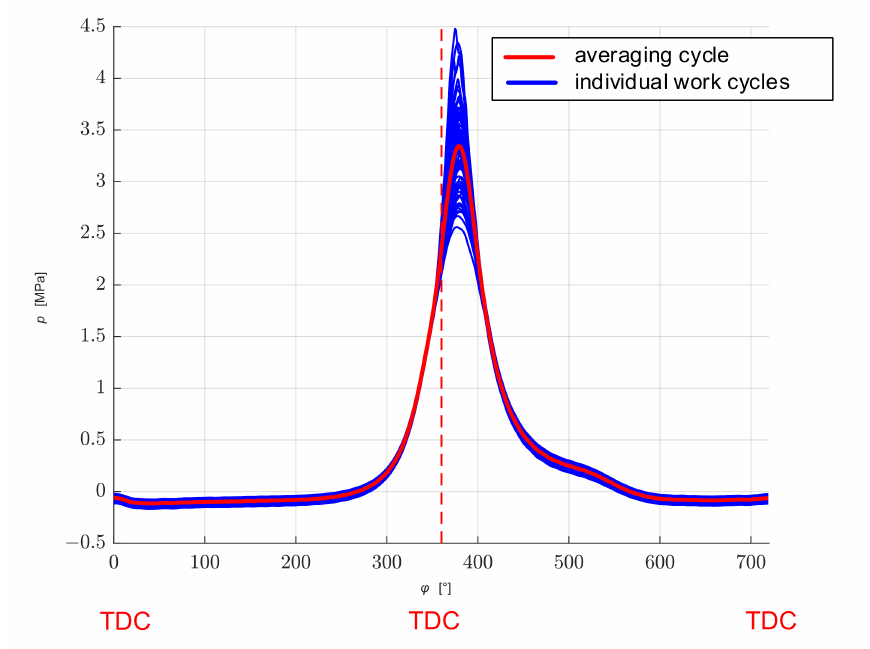
Figure 4. The waveform of 100 consecutive work cycles and the average cycle.